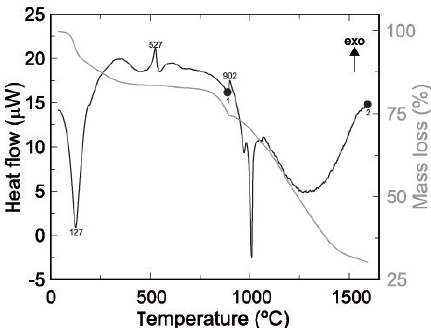
Figure 2. Thermogravimetric analysis of pushcharovskite. The ex- trema in the heat flow are labelled with the corresponding tempera- ture ( ◦ C). Two separate runs were stopped at temperatures, marked by circles on the heat flow curve, and the products were investigated with PXRD. Details are in the